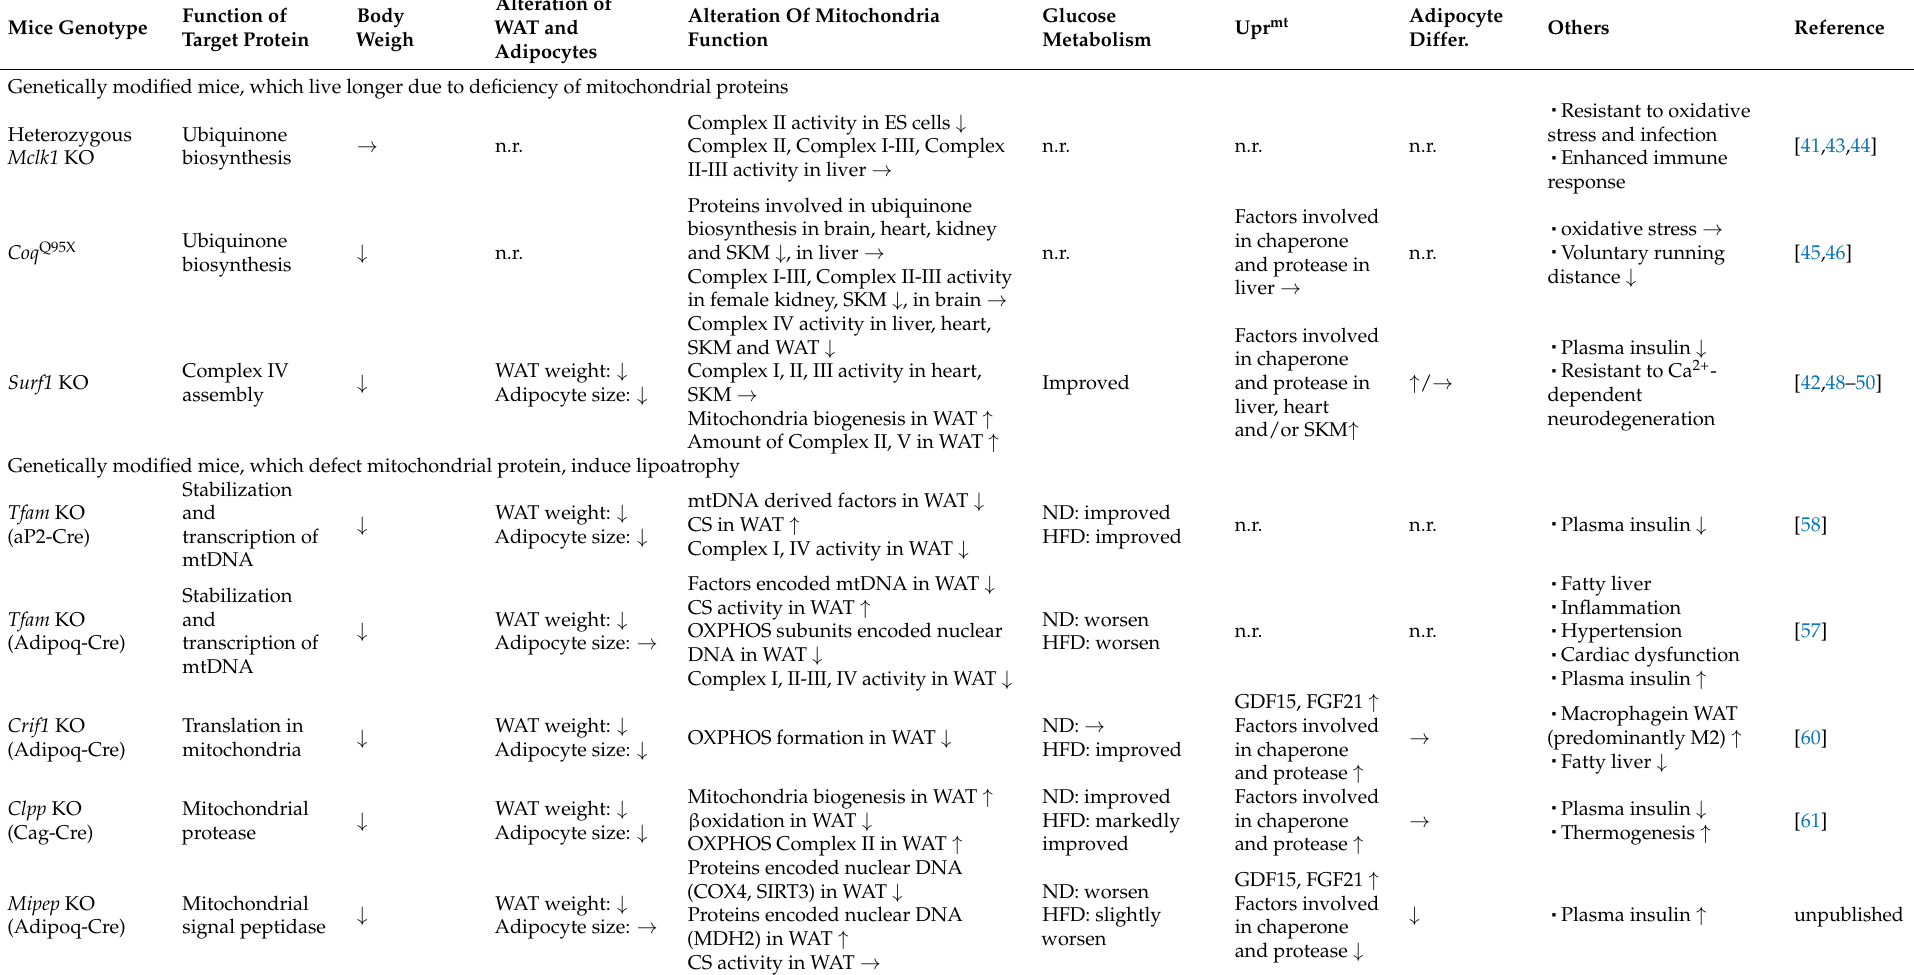
Table 1. Genetically modified mice, which show lipoatrohy due to the defect of proteins involved in mitochondria function.